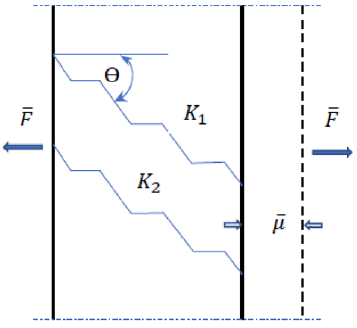
Figure 1. Elastic deformation model in the plant fibre cell